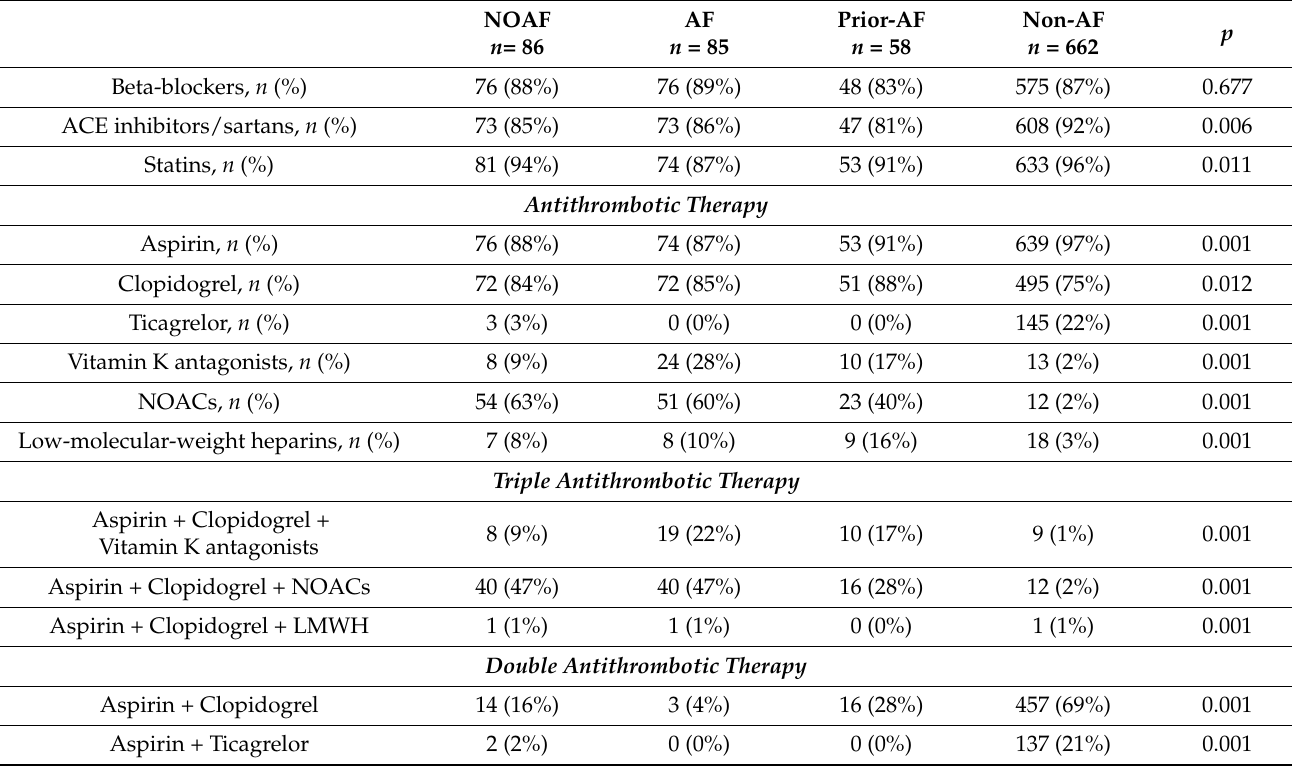
Table 4. Pharmacological treatment at